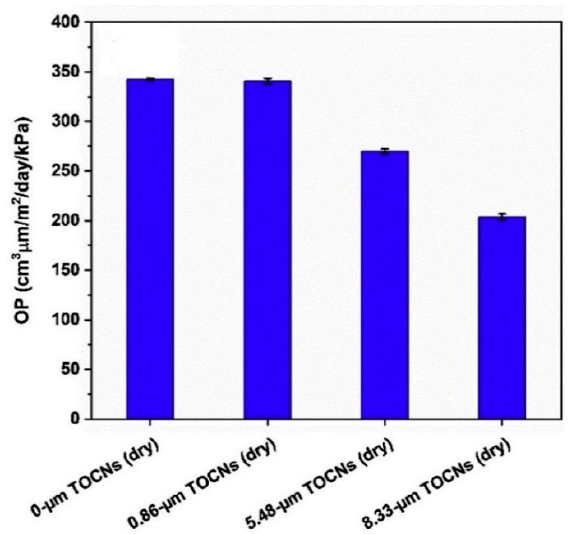
Figure 23. Oxygen permeability (OP) of BOPP (biaxially oriented polypropylene) laminates as a function of TOCN (TEMPO oxidized chitin nanocrystals) dry thickness [93].